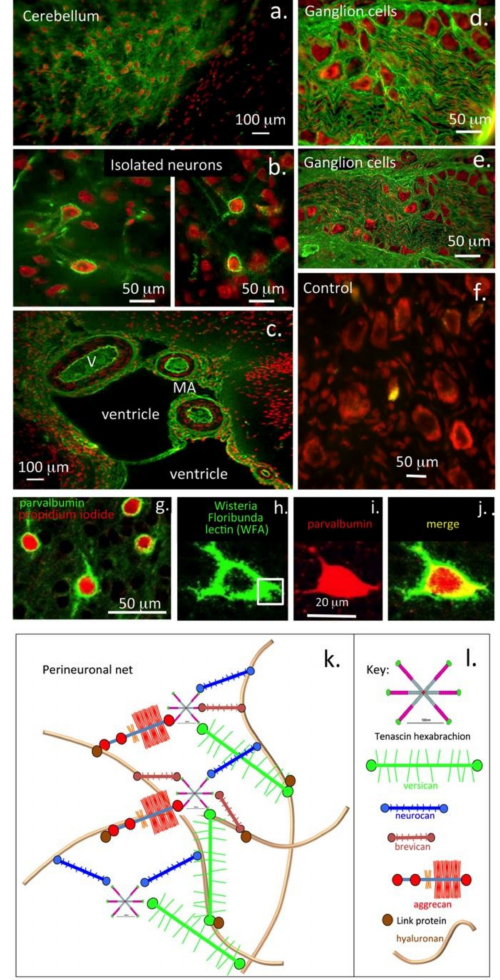
Figure 7. Visualisation of: perineuronal net structures ( a , b ); vascular features ( c ); and ganglion cells ( d , e ) in cerebellum and dorsal root ganglia using MAb 1B5 in confocal images. Immunolocalisation of CS Isomer 1B5 in paraformaldehyde fixed 20- µ m cryo-sections of 24-month-old Wistar rat brain and lumbar dorsal root ganglia. Confocal z-stacked images of IB5 CS stub epitope generated by chondroitinase ABC digestion using Alexa 488 secondary antibody for detection and propidium iodide nuclear counterstain, mounted under coverslips using Vectasheld mountant. Images courtesy of Prof B. Caterson, University of Cardi ff . Copyright Caterson, Hayes 2012 ( a – f ). Immunolocalisation of perineuronal nets surrounding isolated neurons in murine visual cortex using: antibody to parvalbumin ( g , i ); Wisteria floribunda lectin ( h ); and in a merged image ( j ). A schematic model of the perineuronal net structure in the boxed area in ( k ) showing its constituent lectican proteoglycans (aggrecan, versican, neurocan and brevican) interacting with tenascin hexabrachion and hyaluronan to form an aggregate structure stabilised by link protein. A key is provided to explain items in ( k , l ). Figure